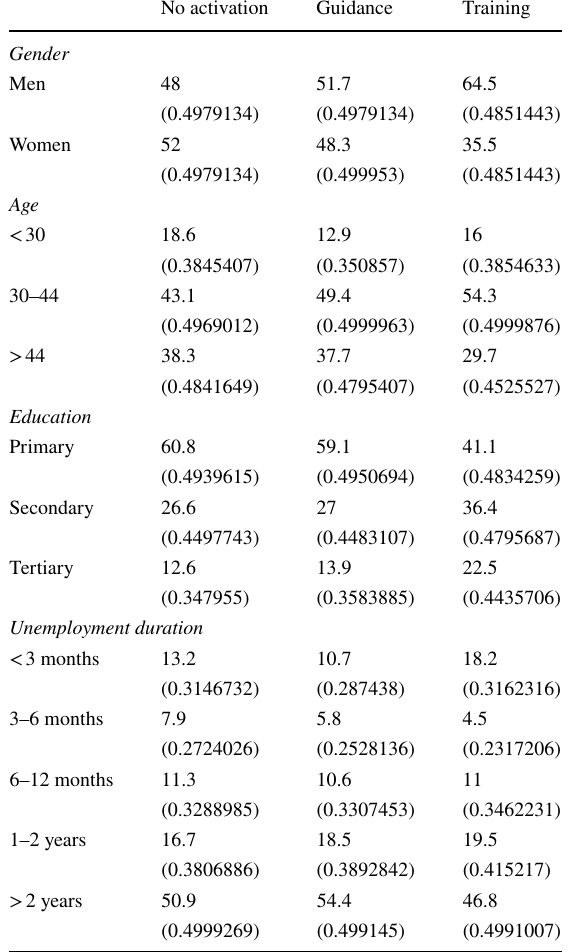
Table 6 Composition of MIS recipients per type of activation